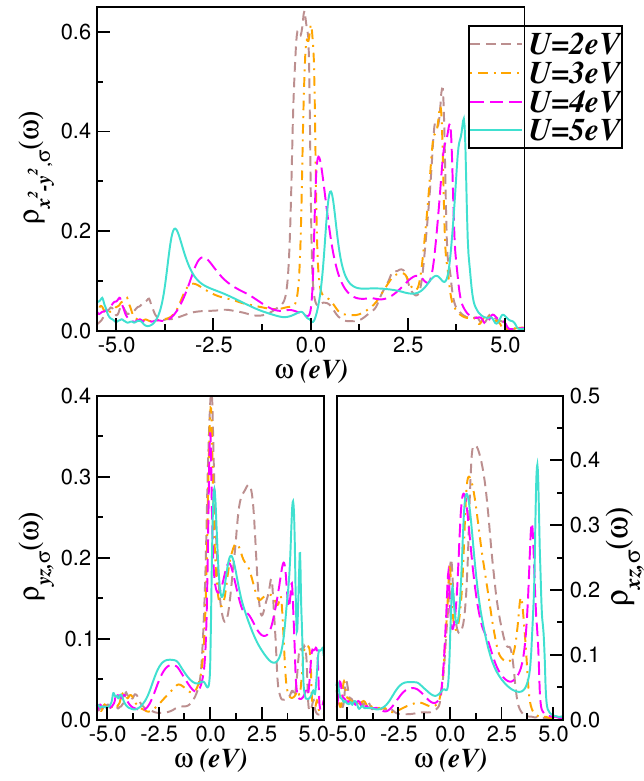
Figure 3. Effect of electronic correlations on the orbital-resolved LDA+DMFT density-of-states (DOS) of monoclinic MO 2 . Worth noticing is the dynamical evolution of the d x 2 − y 2 bonding-antibonding branch, which shows an overall shift to energies above E F due to correlation-induced spectral weight transfer. Also relevant is the formation of a pseudogap-like state at energies near the Fermi level ( E F = ω = 0.0) for U = 5